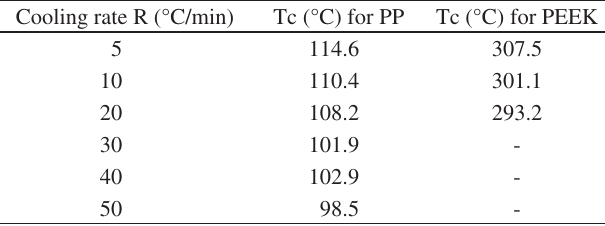
Table 2. Crystallization temperature Tc as a function of cooling rate R for PP 5 and PEEK 6 .